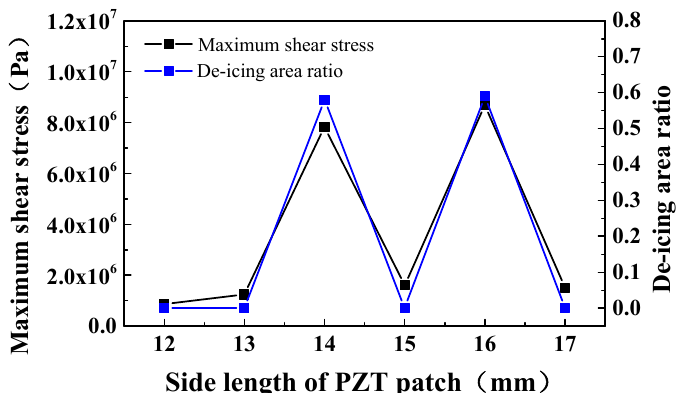
Figure 9. Variations in the maximum shear stress and the deicing area ratio with side length of the PZT patch.